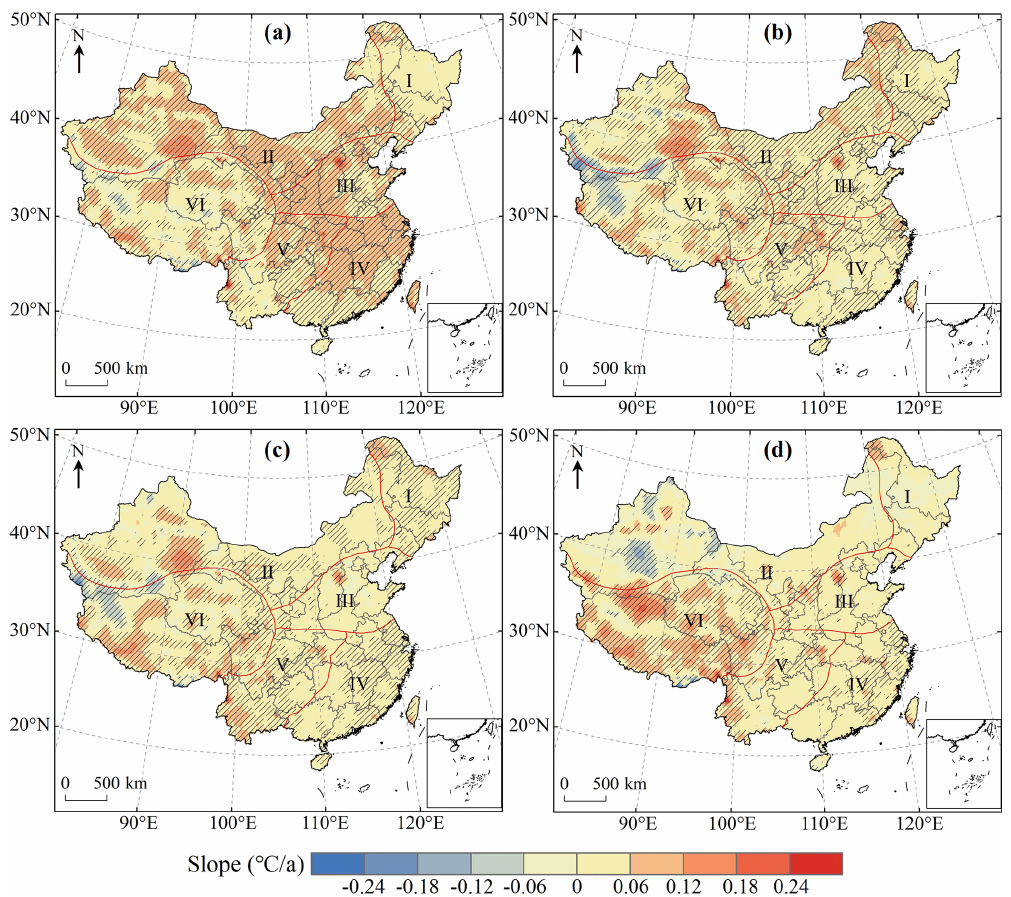
Figure 12. Spatial distribution of the change trend of T max in spring (a) , summer (b) , autumn (c) and winter (d) over China during 1979–2018. The shaded areas indicate trends that are significant at the 0.05 level. Table 5. Change trend statistics of T max in different seasons over China from 1979 to 2018. Significant upward (%) Significant downward (%) Spring Summer Autumn Winter Spring Summer Autumn